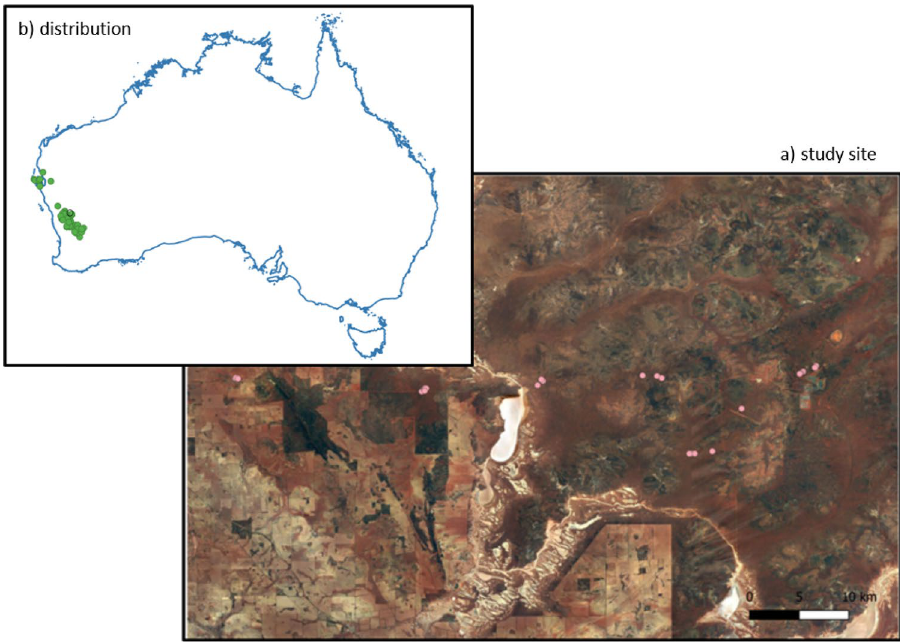
Figure 2. Distribution records of Egernia stokesii badia (orange) according to records maintained by the Atlas of Living Australia (https:// www. ala. org. au/, accessed 16 December2021), and the location of the study site (black), with different LiDAR scanning locations (pink).